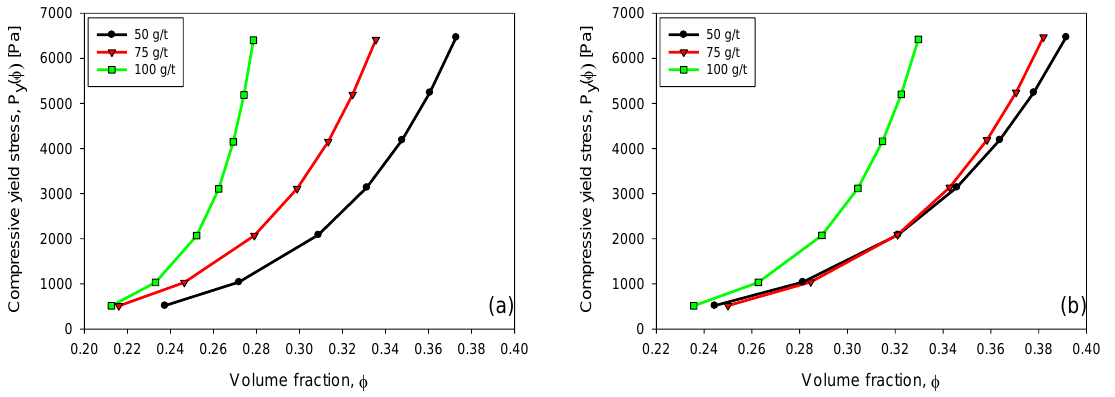
Figure 11. Variation of compressive yield stress versus volume fraction of kaolin suspensions with flocculant dose in IW ( a ) and SW ( b ). Shear rate 180 rpm, solid concentration 5 wt%, flocculation time 15 s, and pH 7.